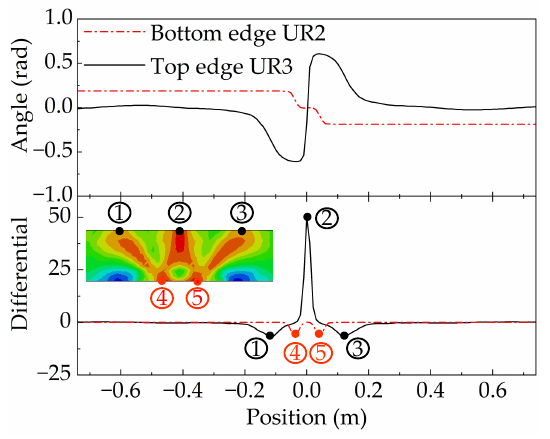
Figure 9. Rotation angle and its differential of side plate’s sides.